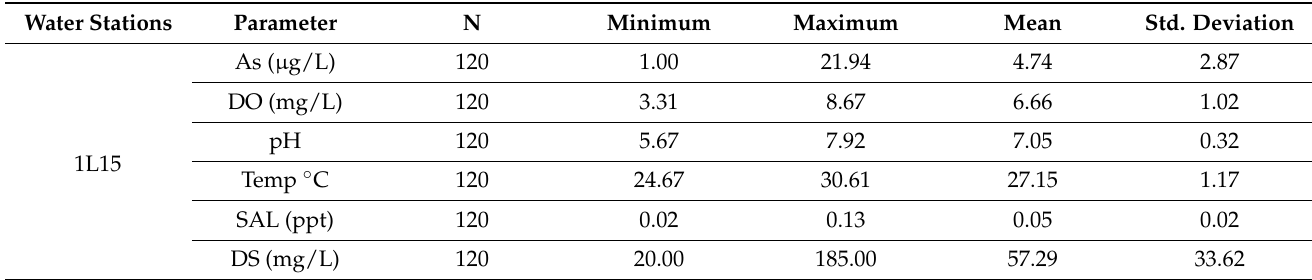
Table 3. As ( µ g/L) concentration at water stations in the Langat River during 2005–2014. Water